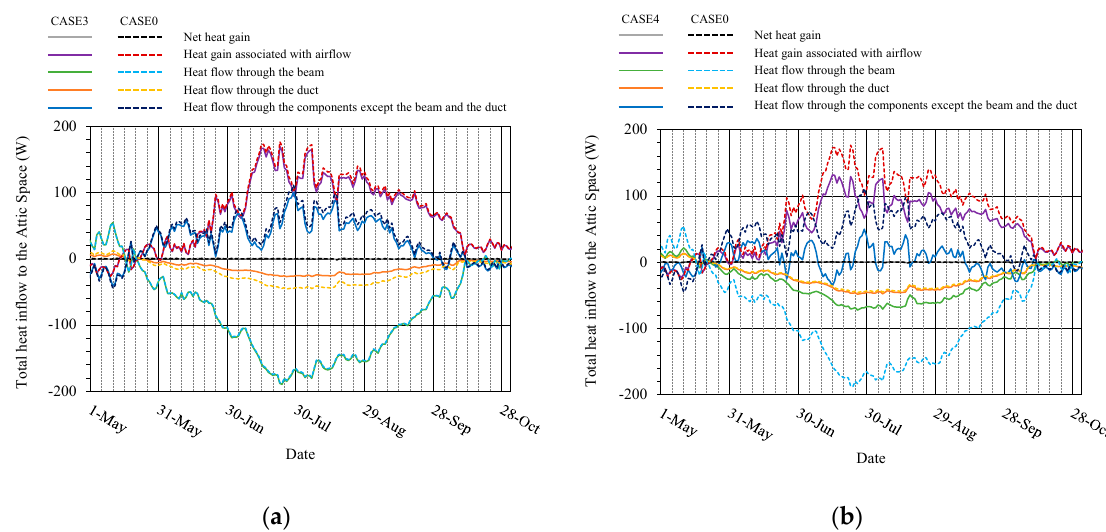
Figure 15. Comparison of the heat flow into the attic space: ( a ) total heat inflow to the attic space in CASES 0 and 3; ( b ) total heat inflow to the attic space in CASES 0 and 4.